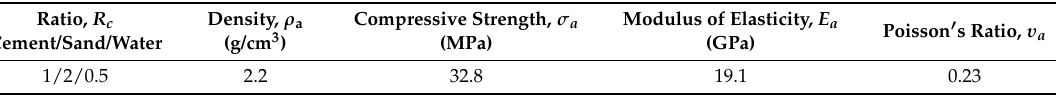
Table 1. Physical and mechanical properties of the